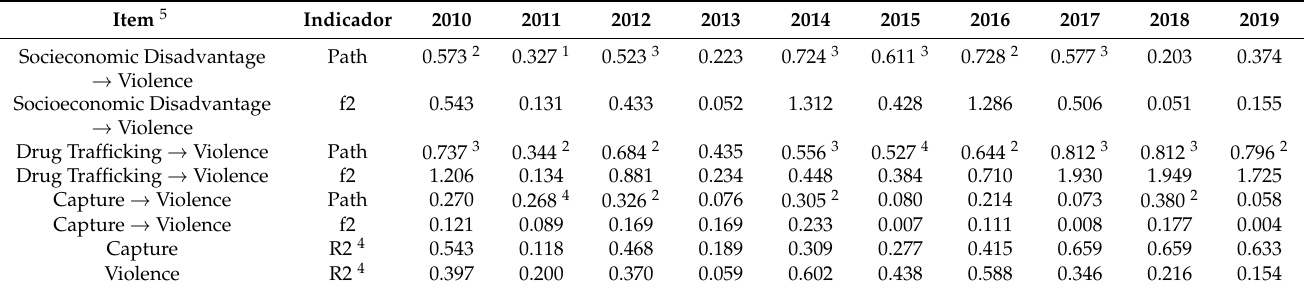
Table 5. Structural Model Assessment: Path Coefficients, f2 and